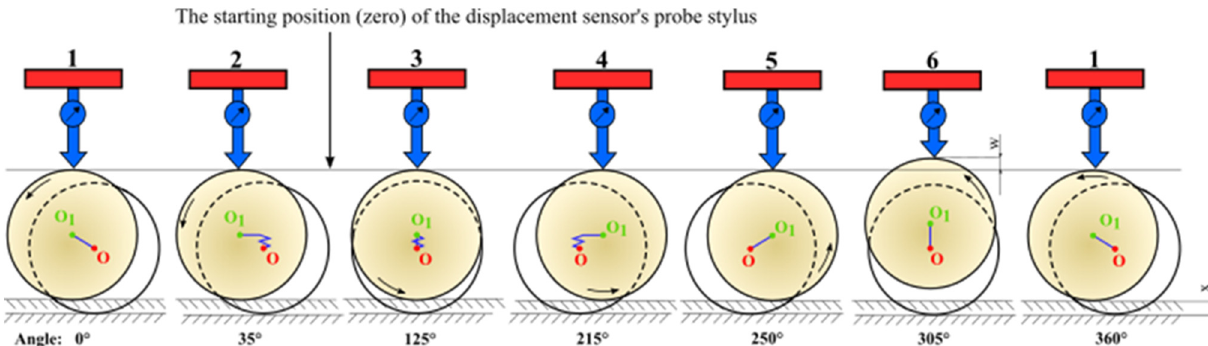
Figure 2. Diagram showing the successive stages of displacements of a journal with eccentricity during crankshaft rotation, for the case where the support is initially positioned upwards in relation to the others ( x —support displacement, OO 1 = e —eccentricity, w —measurable eccentricity). Graphs illustrating the displacement path of the sensor stylus, presented in Cartesian and polar coordinate systems, are shown in Figure 3a,b, respectively. In the case under consideration, it was assumed that the eccentricity value e = 0.03 mm and that the center of the journal in the initial angular position was at the point marked 1 (Figure 2). The support, in order to maintain contact with the journal, is shifted upwards in relation to the others by a value of x = 0.017 mm. As a result, the eccentricity corresponding to the segment OO 1 in the initial angular position of the crankshaft (rotation angle 0°) is deviated to the left by an angle of 55° with respect to the vertical direction. The measurable eccentricity value in this case is w = 0.013 mm.